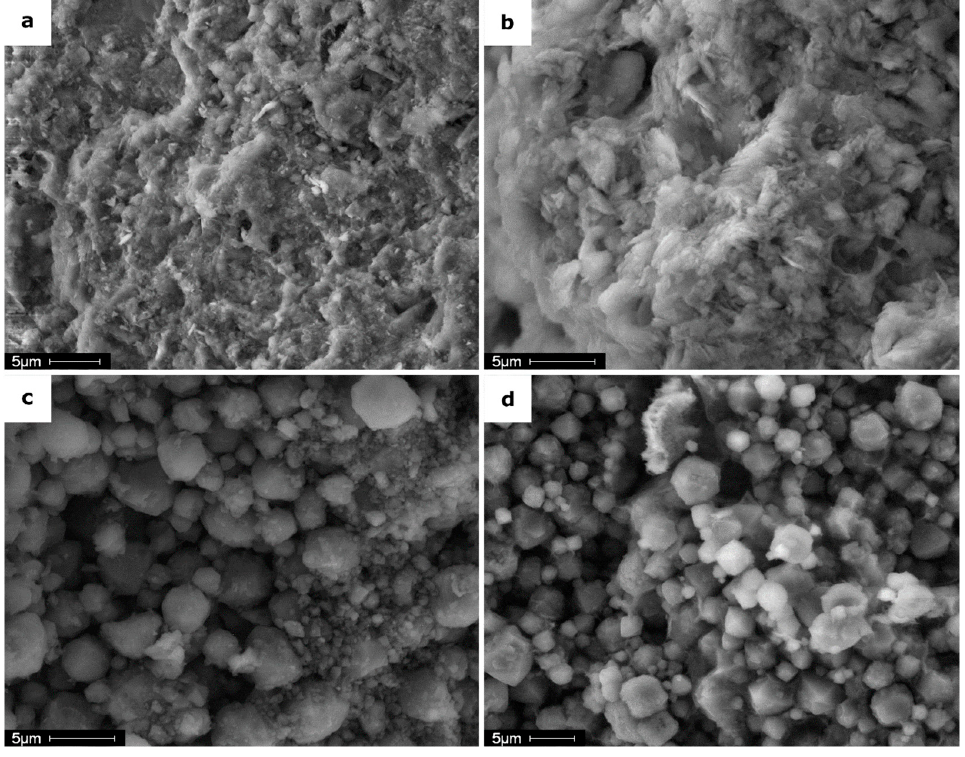
Figure 7 . SEM results of clean clinoptilolite ( a ); Zn 2+ -contaminated clinoptilolite ( b ); clean zeolite A ( c ) and Zn 2+ -contaminated zeolite A ( d ) .